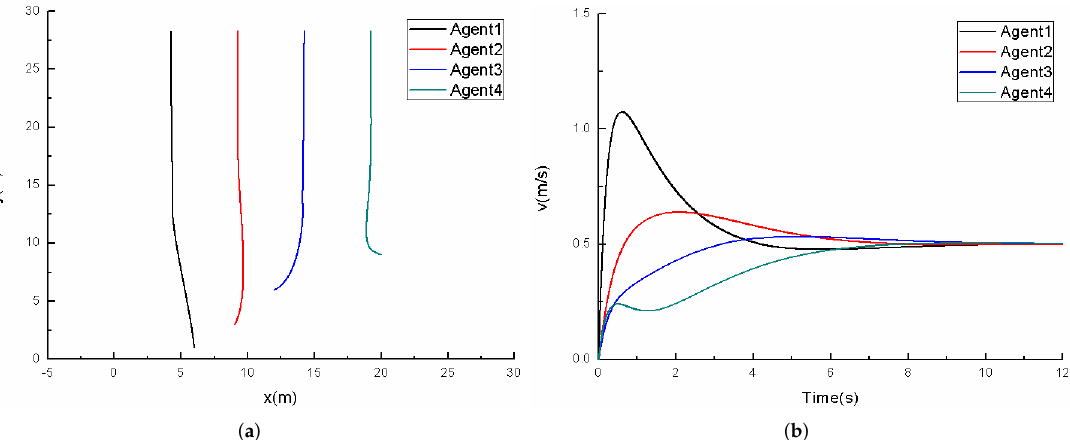
Figure 6. Position and velocity trajectories of second-order differential robot system (27) ( τ ij ( k ) = 0). ( a ) Position trajectories. ( b ) Velocity trajectories.